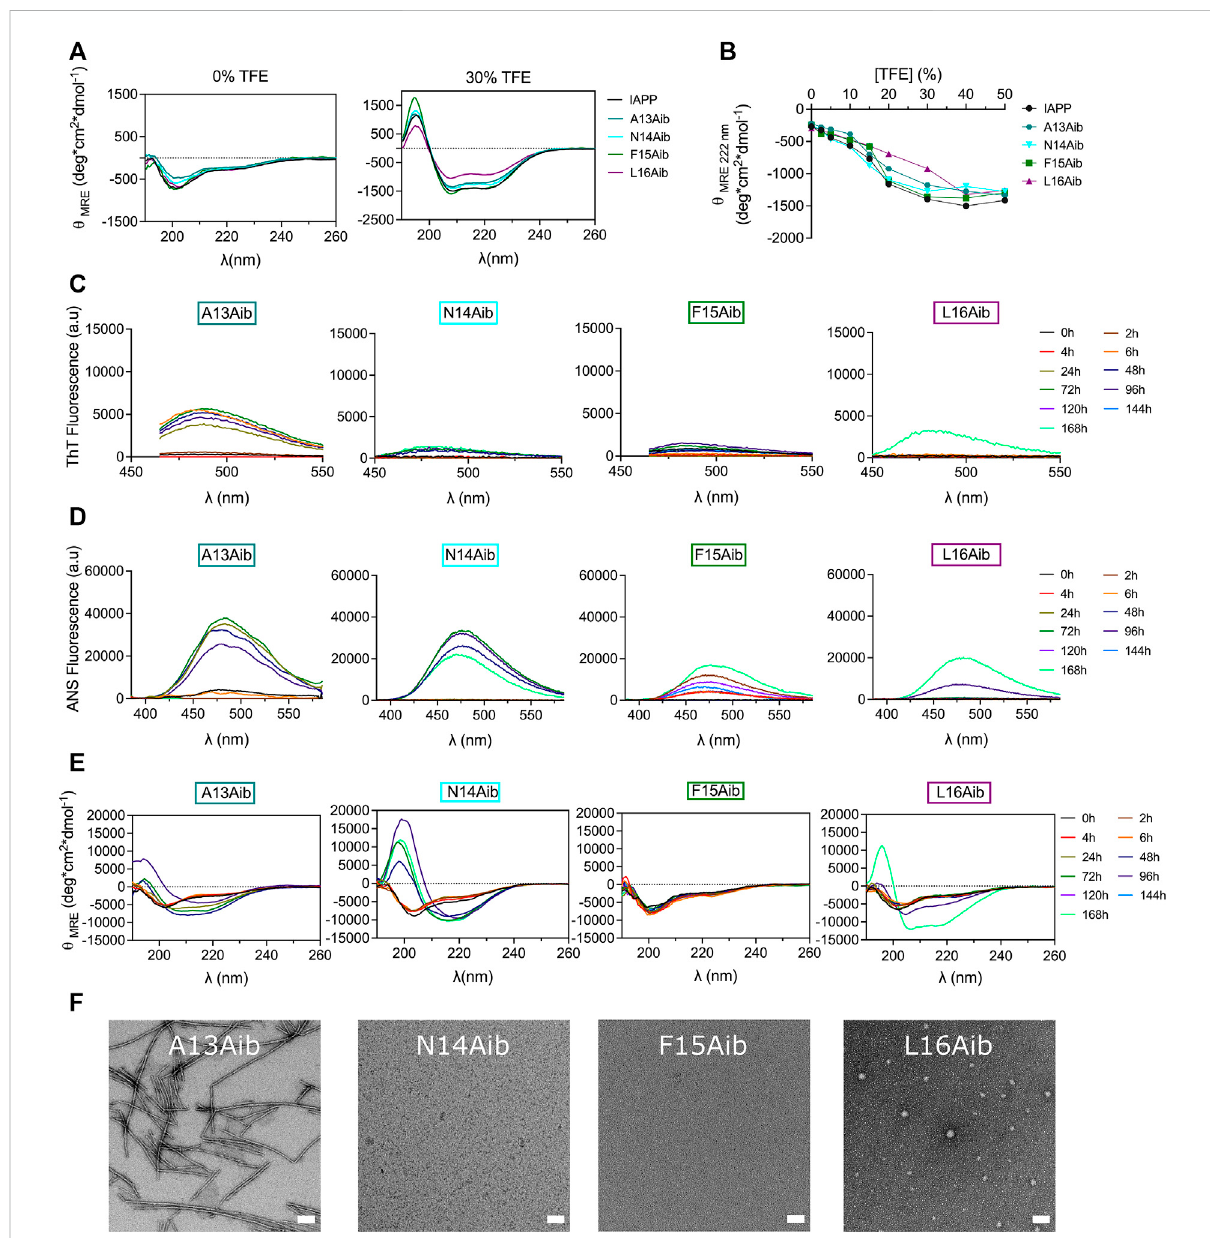
FIGURE 8 Effects of backbone α -methylation on IAPP amyloid self-assembly. (A) Far-UV CD spectra of peptides in Tris-HCl 20 mM in presence, or absence, of 30% TFE. (B) Effect of TFE on the mean residue ellipticity measured at 222 nm. (C – E) Peptides were incubated under